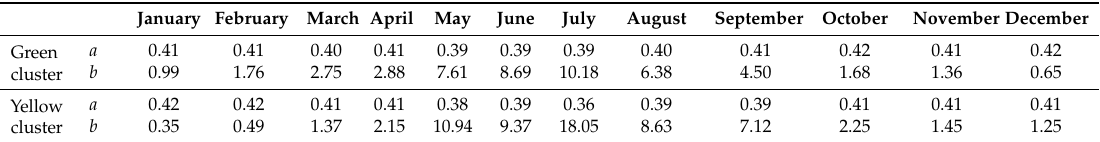
Table 3. Values of slope and intercept for the